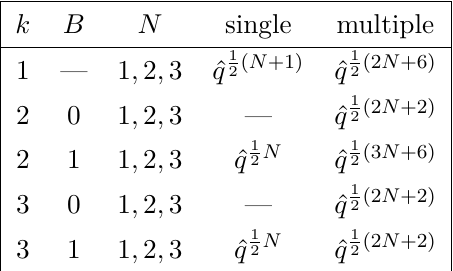
Table 3 . Results of the comparison for the ABJM theory. k , B , and N are the Chern-Simons level, the baryonic charge, and the rank of the gauge group. The column “single” shows the orders of the correction due to single-wrapping configurations. The column “multiple” shows the orders of the errors due to multiple-wrapping